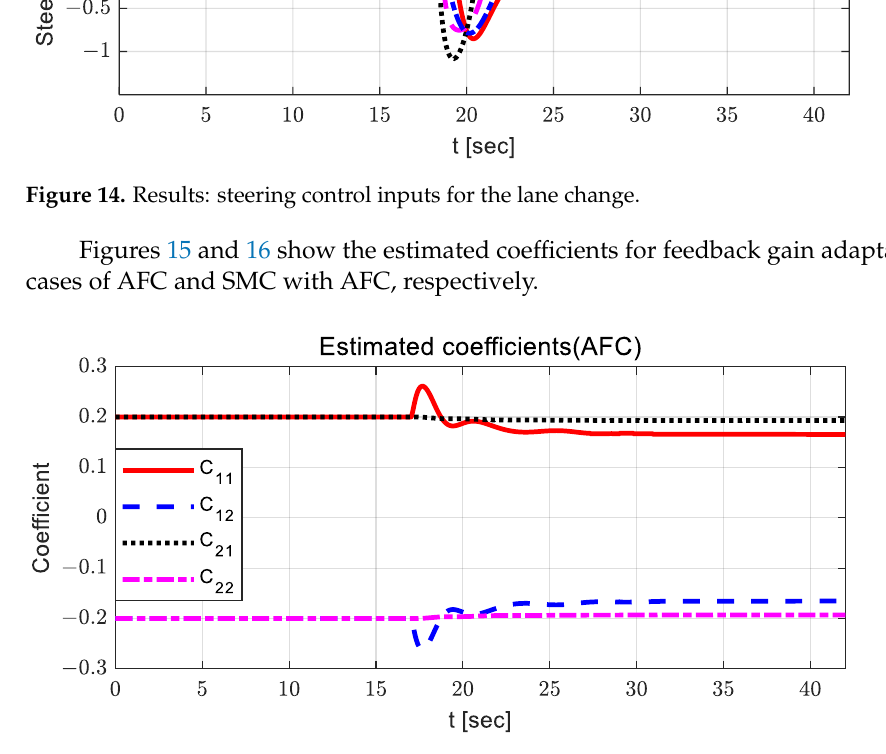
Figure 15. Results: estimated coefficients in the case of AFC for the lane change.